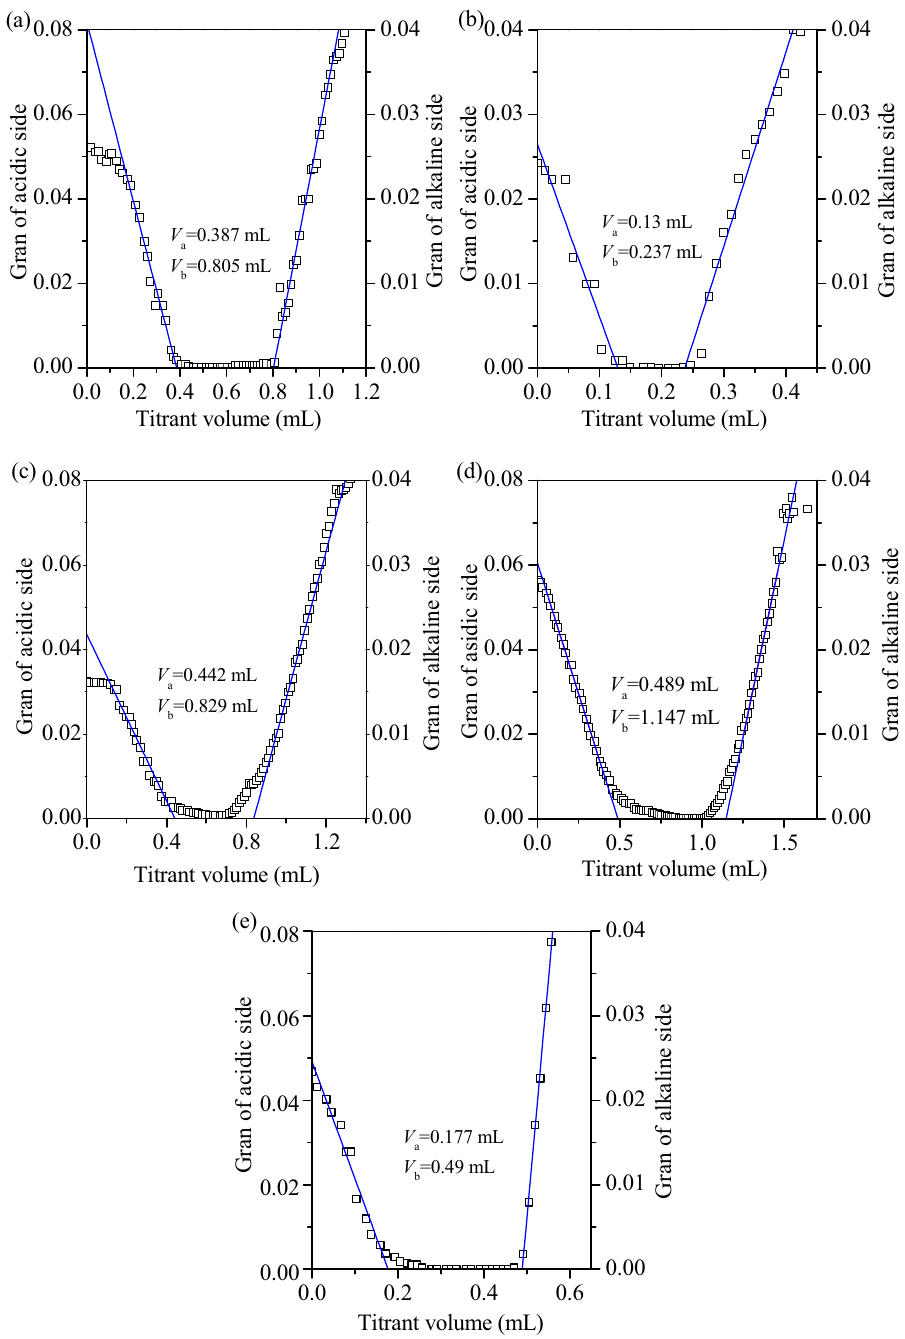
Figure 6. Gran plots of ( a ) S500, ( b ) S700, ( c ) Na300, ( d ) Na500 and ( e )